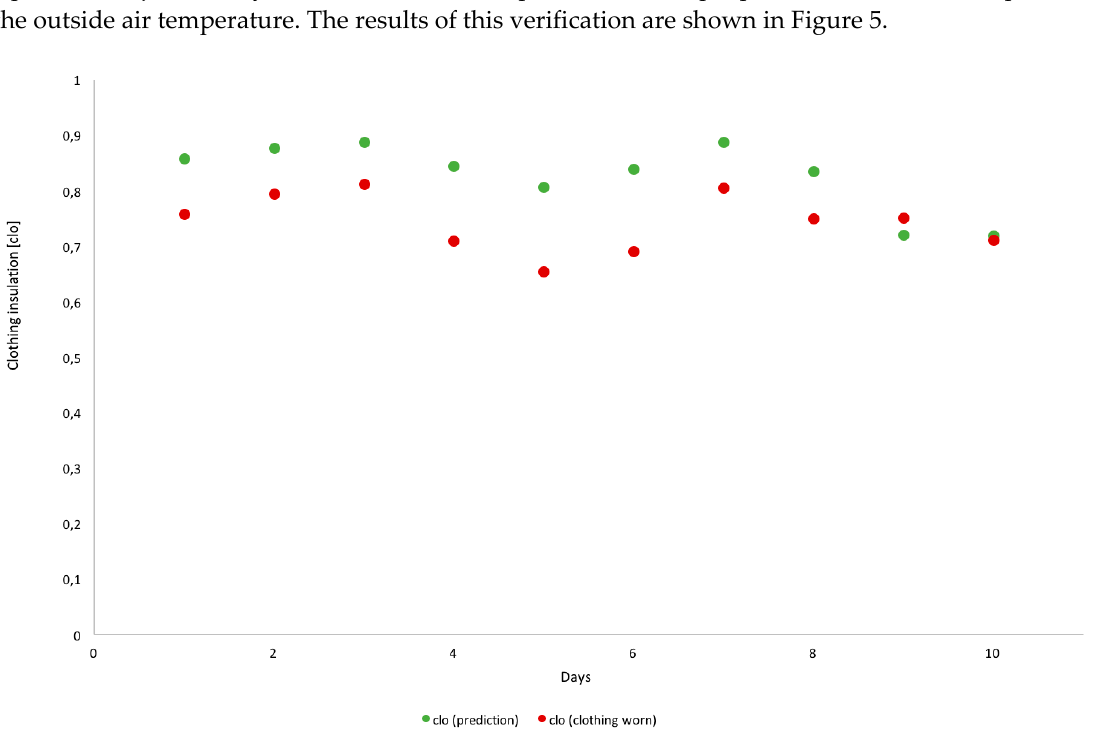
Figure 5. Comparison of the calculated average clo value (12 h) with the average clo value of the clothing